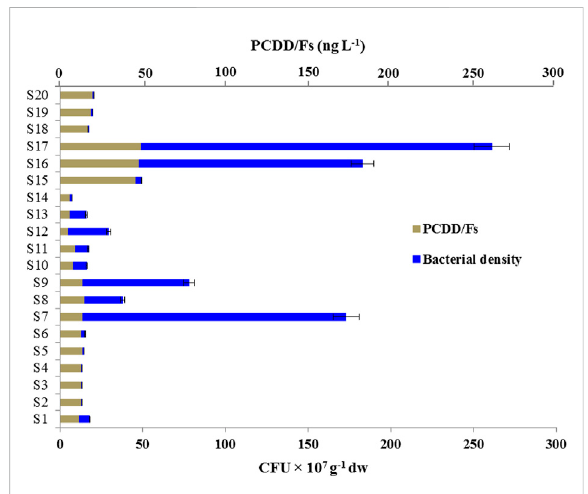
FIGURE 2 Density of microbial communities in soil samples with respect toPCDD/Fs concentrations.Thedensitiesofsoilmicrobial communities are expressed as CFU × 10 7 per g of dry soil (dw). Level of PCCD/Fs in soil samples was determined as described before. CFUs were determined in triplicate. Values are means ± S.D ( n =